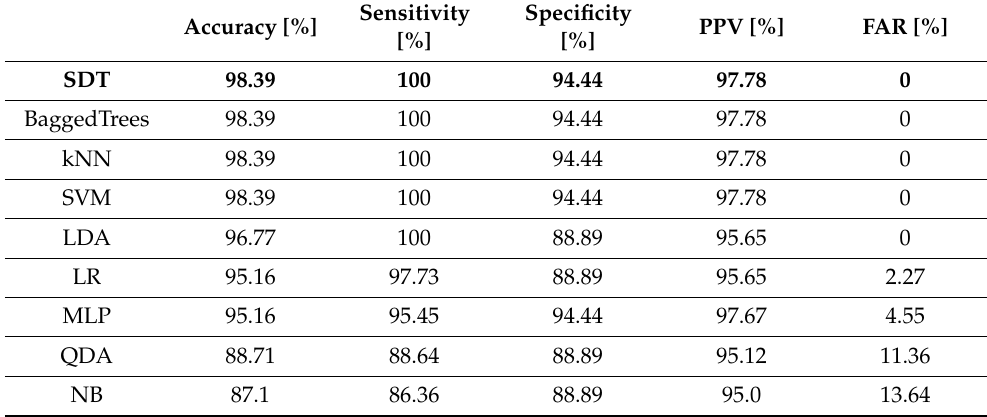
Table 2. Result of classification based on 220 samples of signal and 4th polynomial degree for other